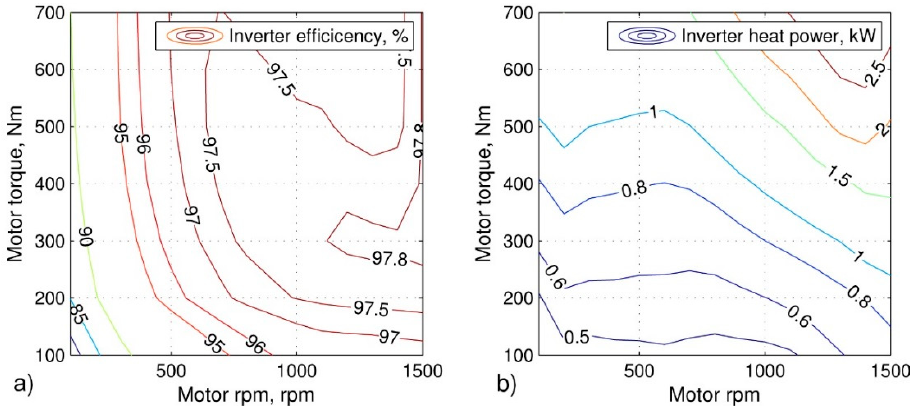
Figure 5. Characteristics of the inverter: ( a ) Efficiency and ( b ) dissipated heat power.